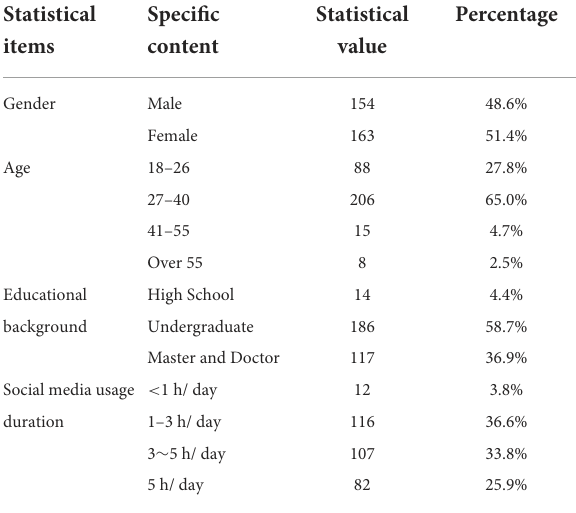
TABLE 1 Statistical table of basic information on effective